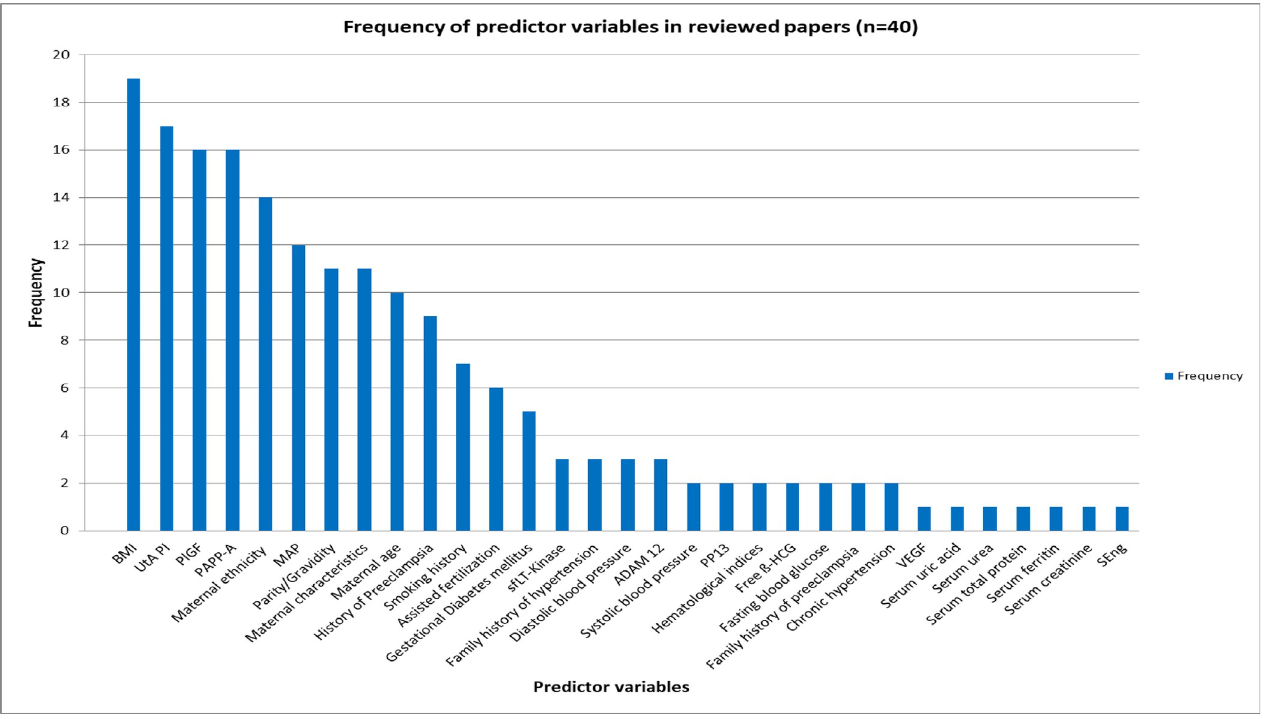
Fig 2. Frequency of predictor variables in the prediction